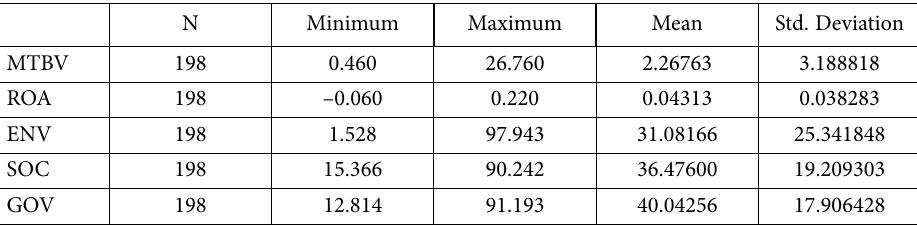
Table 5. Descriptive statistics (Asia) (source: own construction by using SPSS)